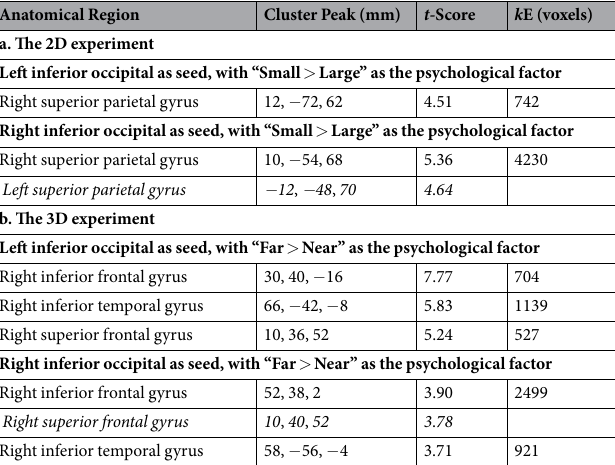
Table 2. Results of the PPI analyses in the 2D and virtual 3D experiment. The coordinates (x, y, z) correspond to MNI coordinates. Displayed are the coordinates of the maximally activated voxel within a significant cluster as well as the coordinates of relevant local maxima within the cluster (in